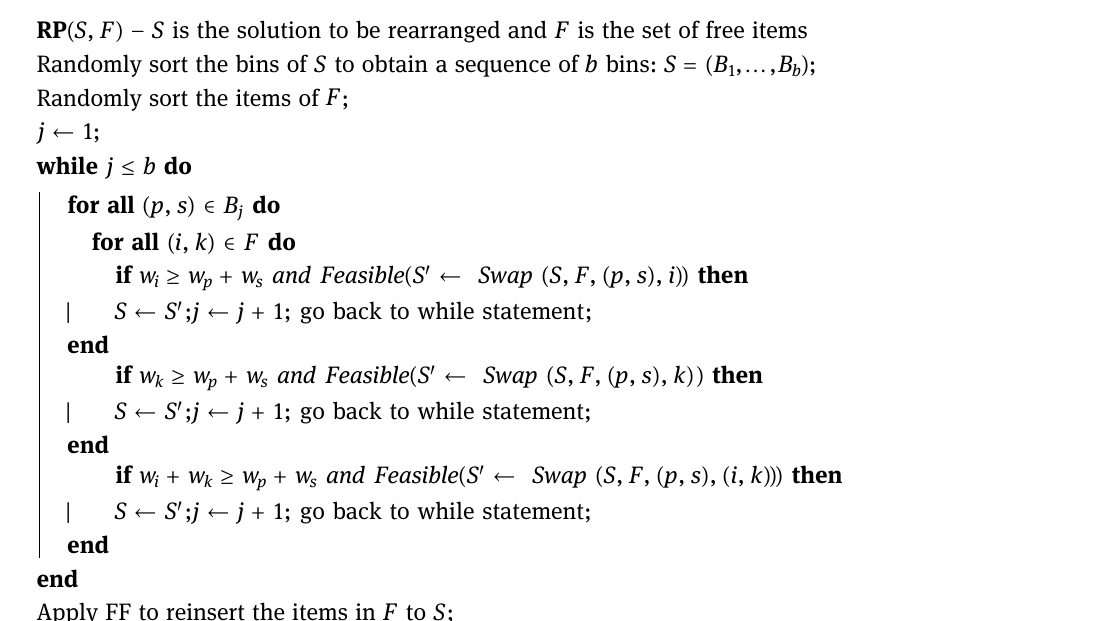
Algorithm 6 : Pseudocode of RP ( Rearrangement by Pairs